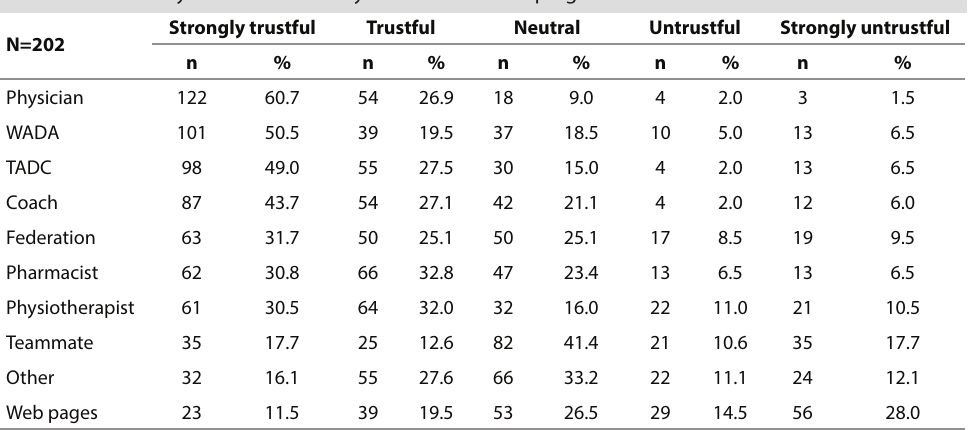
TABLE 6. Reliability of sources used by athletes about doping